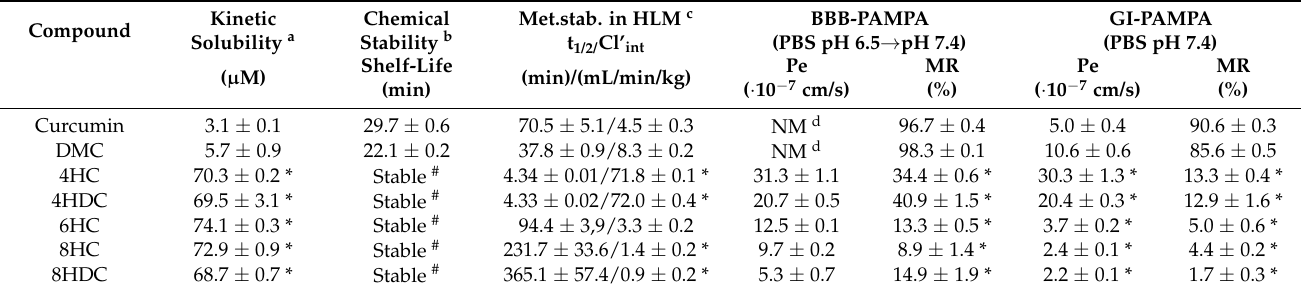
Table 2. Experimental physicochemical and in vitro pharmacokinetic profile of curcumin, demethoxycurcumin and their hydrogenated analogues. P e : effective permeability, MR: membrane retention. Kinetic solubility, in vitro human microsomal t 1/2 and P e , and the MR values of permeability measurements represent mean ± S.E.M; *: p < 0.001 by one-way ANOVA and Bonferroni post-hoc test as compared to the corresponding parent compound, i.e., curcumin for 4HC, 6HC and 8HC, and DMC for 4HDC and 8HDC, n =